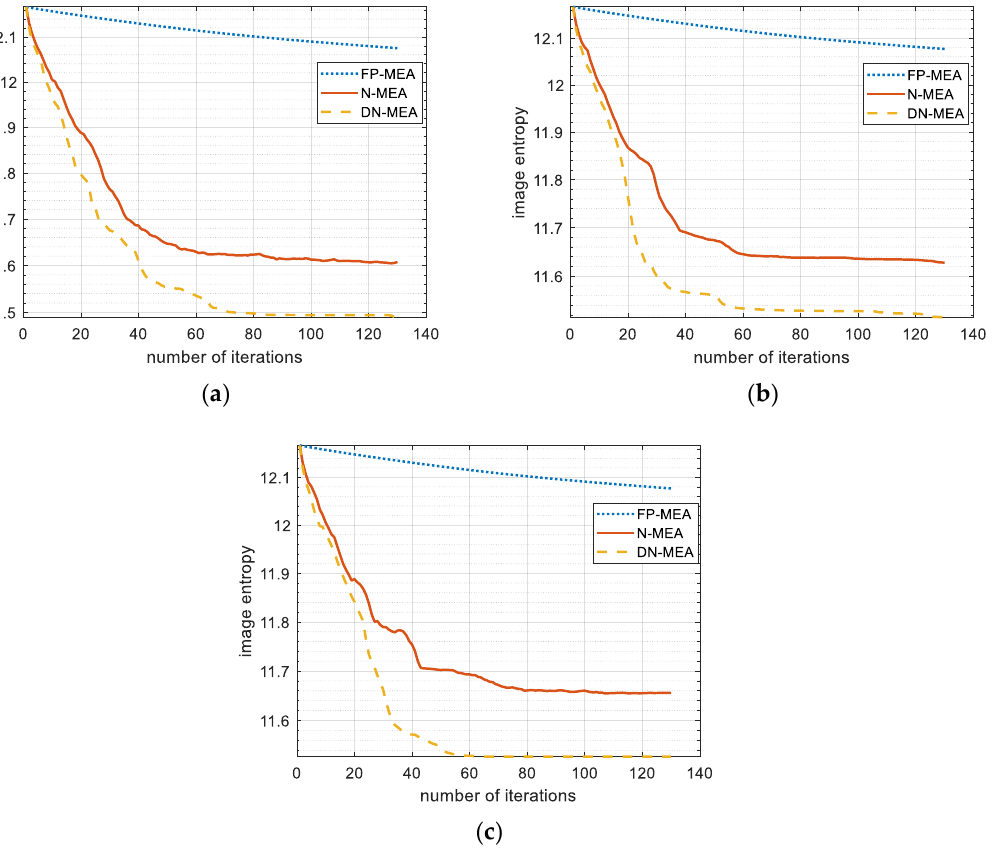
Figure 13. Curves of image entropy versus the number of iterations of different methods and SNR conditions: ( a ) without the addition of noise; ( b ) −5 dB; ( c ) −10 dB.